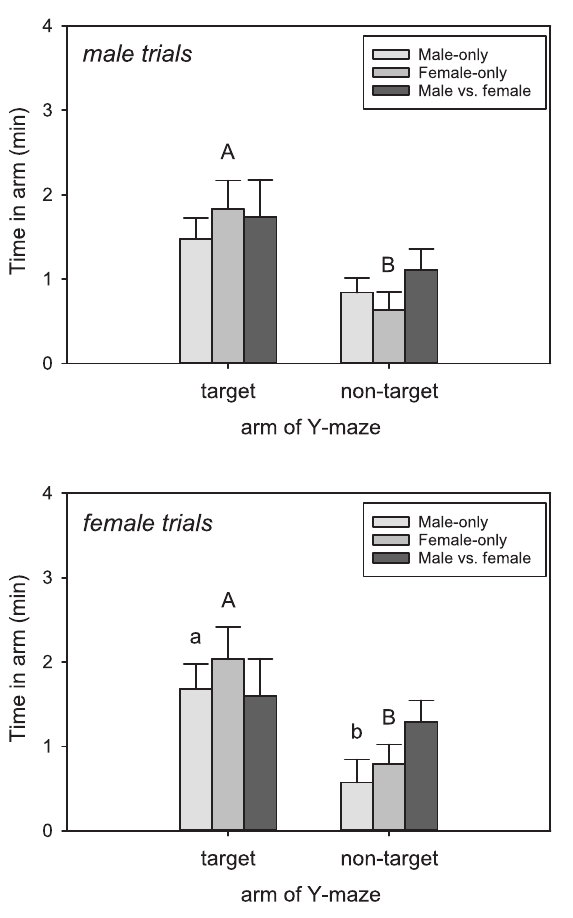
(P < 0.05) pairwise comparisons between target and non-target arms. Lowercase letters = 0.05 < P < 0.1. Bars are means